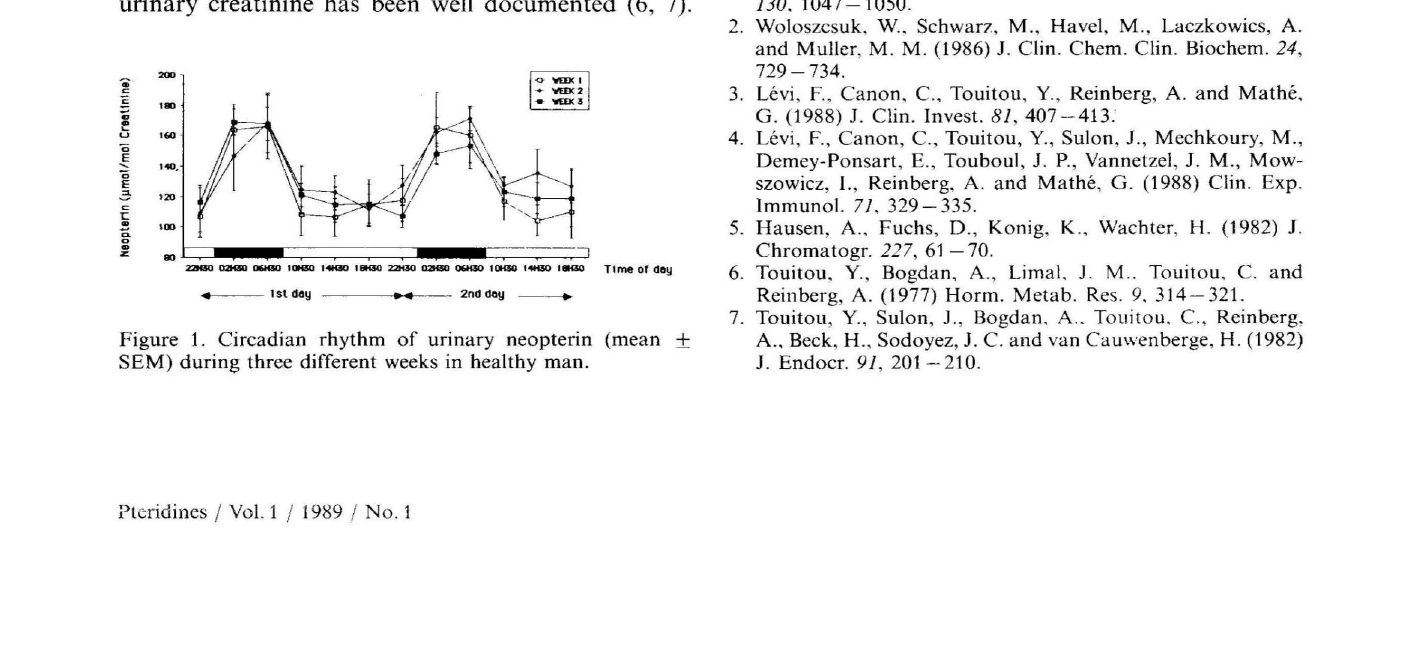
Figure 1. Circadian rhythm of urinary neopterin (mean ± SEM) during three different weeks in healthy man.